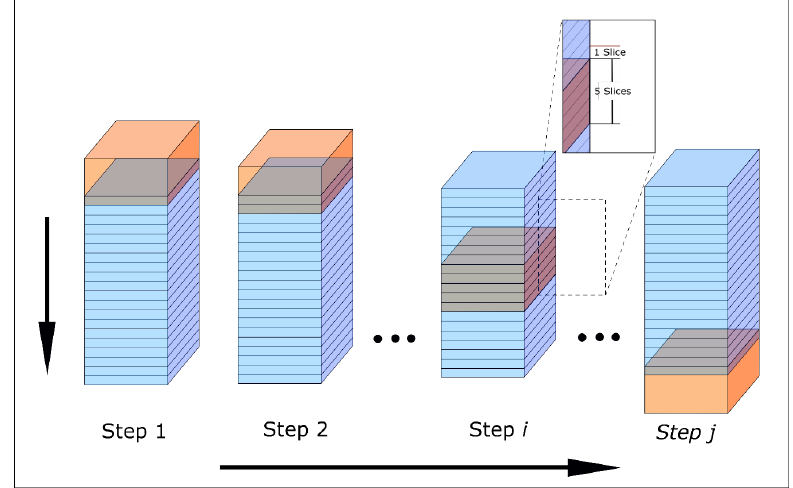
Figure 5. The principle of the moving cuboid filter in a single column. The orange cuboid is the moving cuboid filter. It starts from Step 1 and moves down one slice in Step 2. 𝑖 is the number of steps in the 3D column, and Step 𝑗 is the final step. Remote Sens. 2019 , 11 , x FOR PEER REVIEW